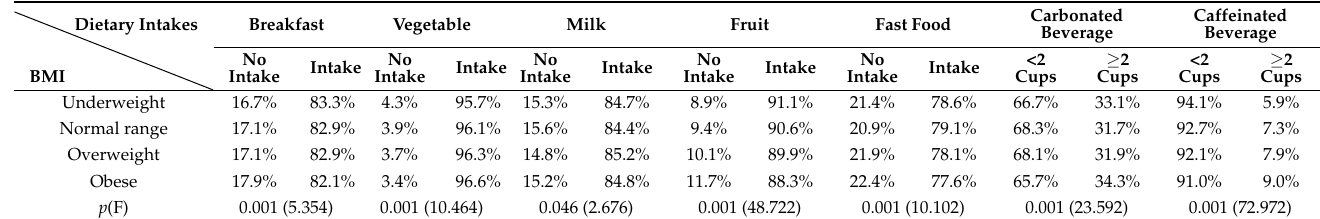
Table 6. Associations of dietary intakes with BMI.